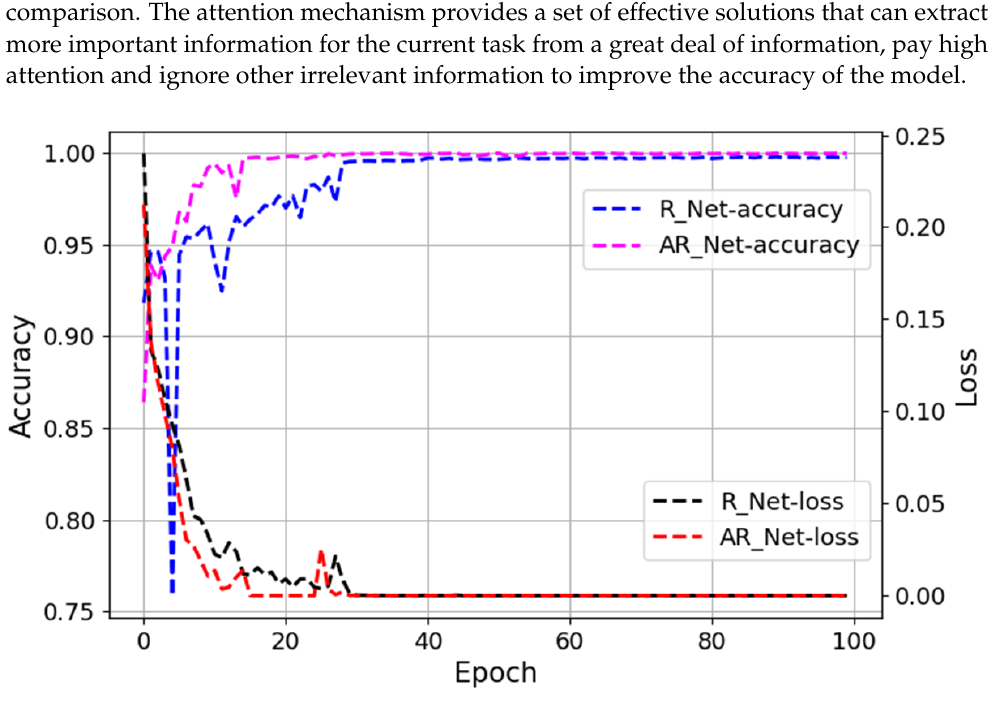
Figure 6. Curve of loss and accuracy on validation (effects of adding attention mechanism to the model).